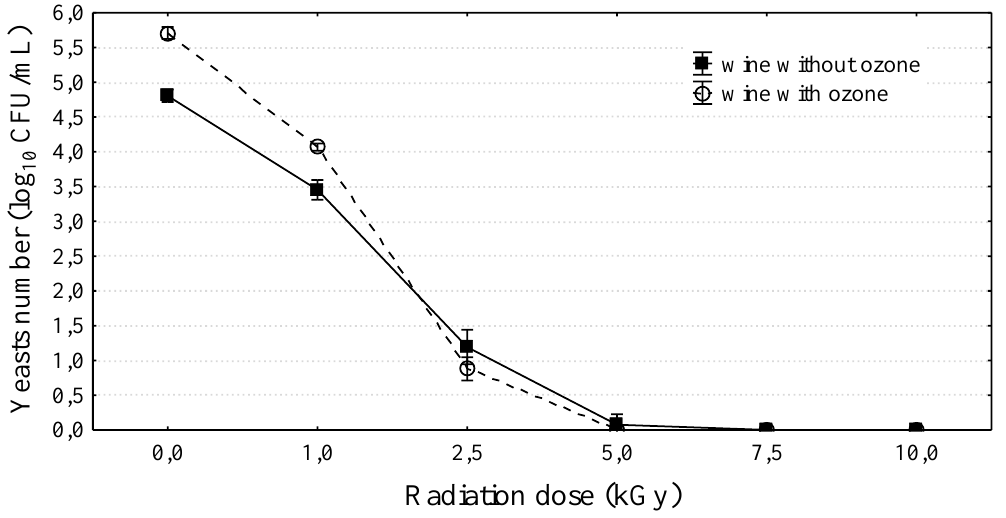
Figure 4. The influence of irradiation doses on yeasts survival in wine (15 day wine). Means and 95% standard deviations are marked in Figure. Table 2. Changes in the color of wine under the influence of ozonation (5 min), irradiation, and